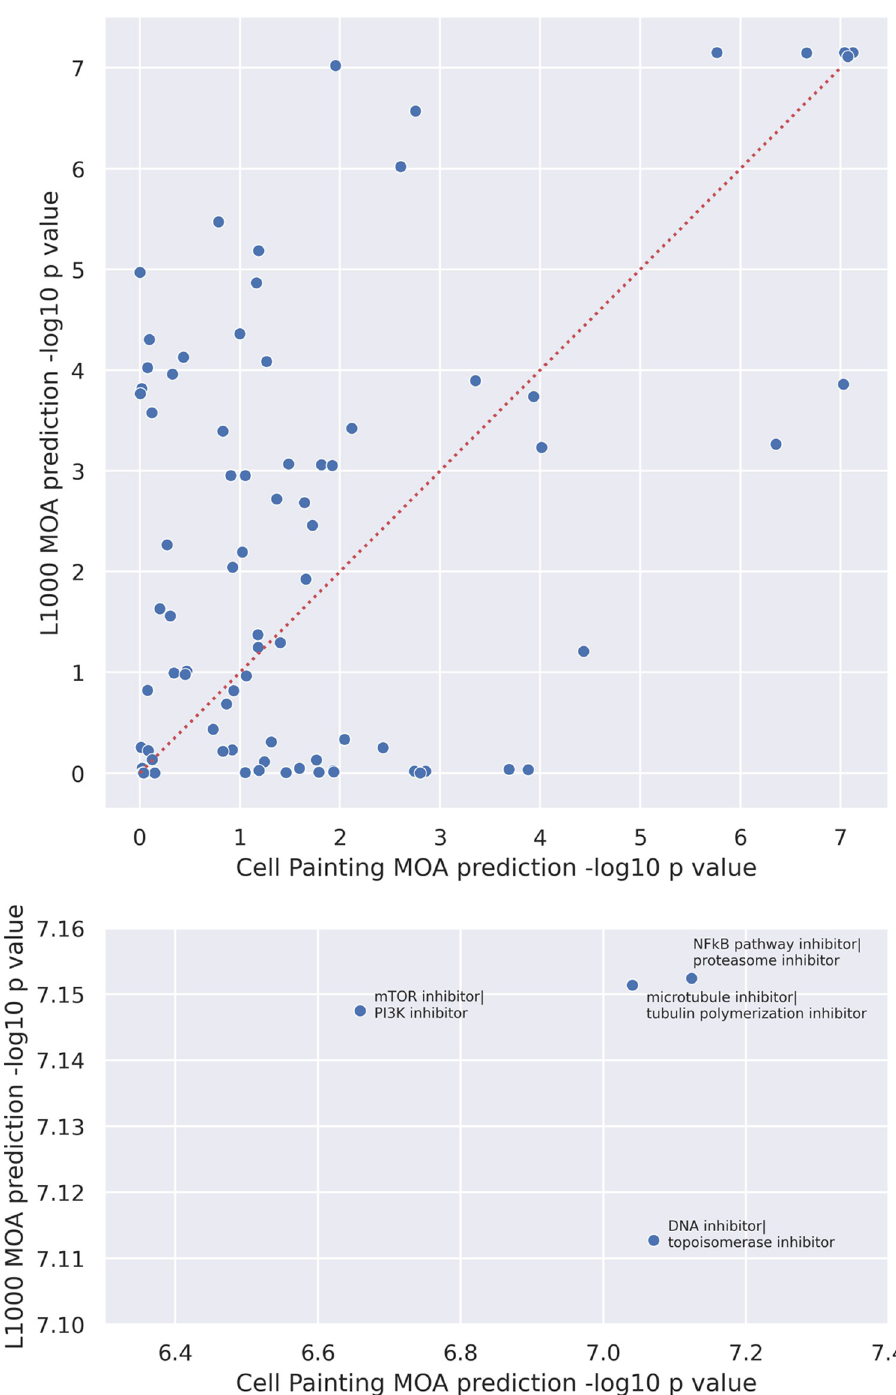
Fig 5. Scatterplot of L1000 vs Cell Painting MOA performance for MMD-VAE, with outliers ( > 3 stds) excluded. Performance is determined by the test scores between the L2 distance between predicted and real profile and the distribution of L2 distances from shuffling MOAs 10 times. Top —all “A \ B” combinations; bottom —only the top 5 “A \ B” with labels.